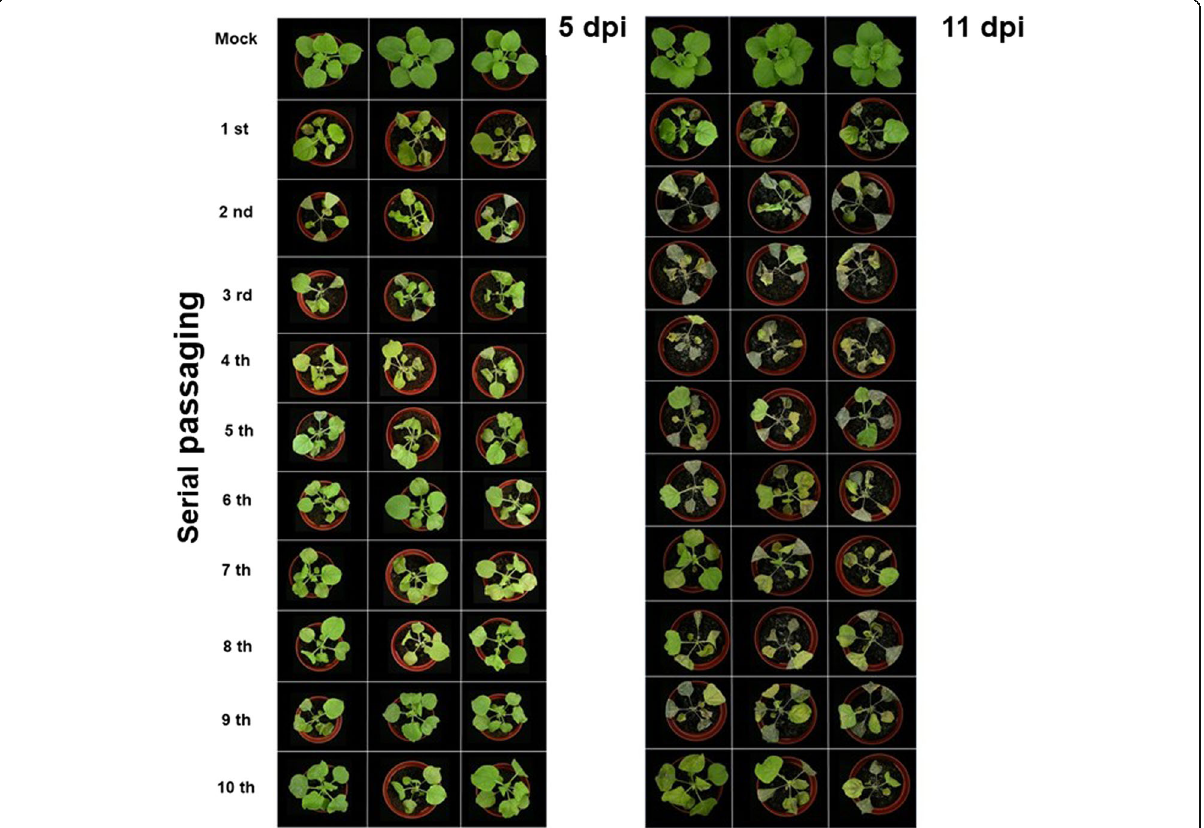
passaging. Of the five mutated clones of the first-round inoculation, four clones showed only one nucleotide of guanine (G) was substituted by an A nucleotide. How- ever, in the second round of passaging, there were six clones with one G changed to A nucleotide. The number of a single nucleotide change increased in subsequent serial passaging. In the fifth serial passaging, four nucle- otides downstream of the introduced internal poly(A) tract were deleted. In the eighth passaging, extensive de- letion of 22, 25 and 42 nt were observed.